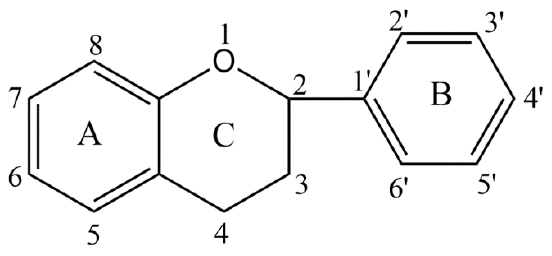
Figure 20. Basic skeleton of C6-C3-C6